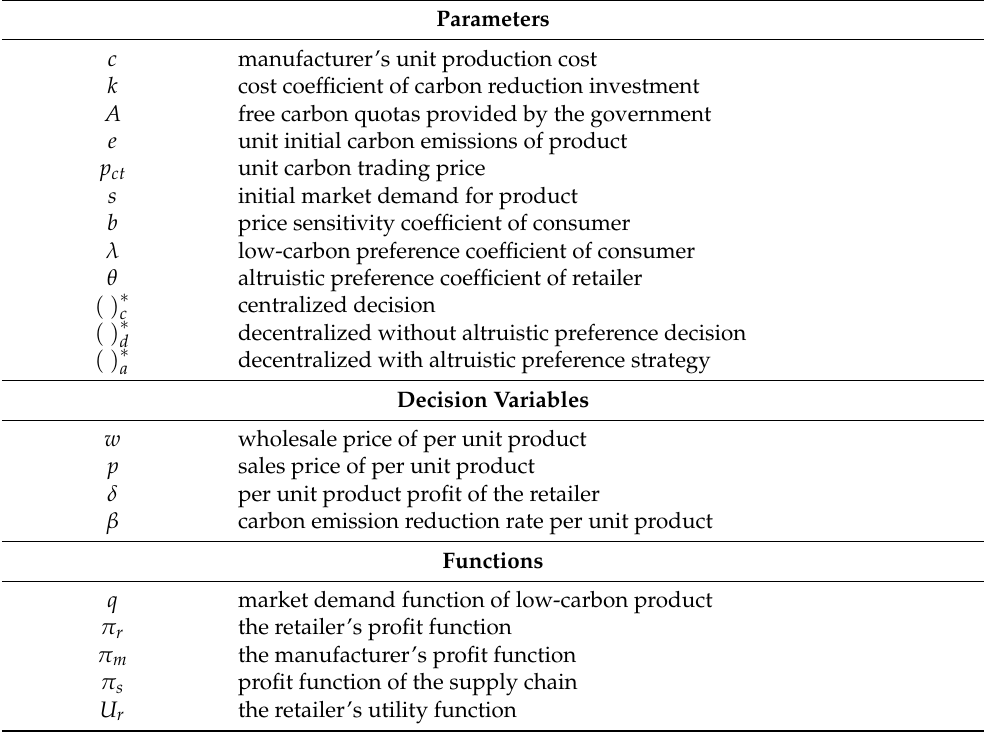
Table 2. Main Parameters and